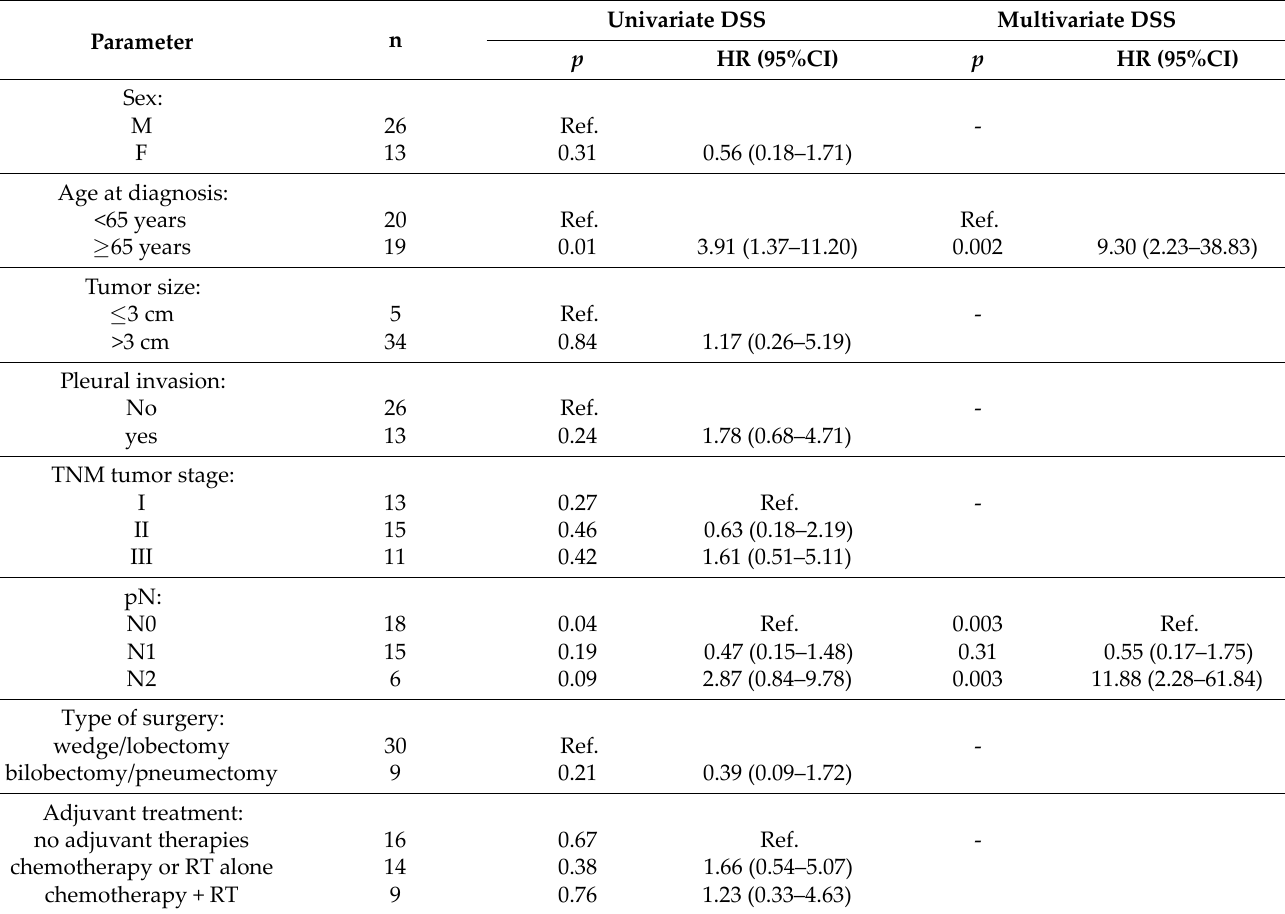
Figure 3. Disease-specific survival. ( A ) Disease-specific survival (DDS) in the entire cohort of pa- Figure 3. Disease‑specific survival. ( A ) Disease‑specific survival (DDS) in the entire cohort of pa‑ tients. DSS according to age ( B ) and lymph node metastasis — pN status ( C ). tients. DSS according to age ( B ) and lymph node metastasis—pN status ( C ). At univariate analysis (Table 4), men showed a slightly shorter DSS than women (me- Table 4. Cox regression univariate and multivariate analysis of prognostic factors influencing the dian DSS 50 months vs. ‘not reached,’ respectively, HR = 1.69, 95%CI = 0.62 – 4.59, p = 0.30). disease‑specific